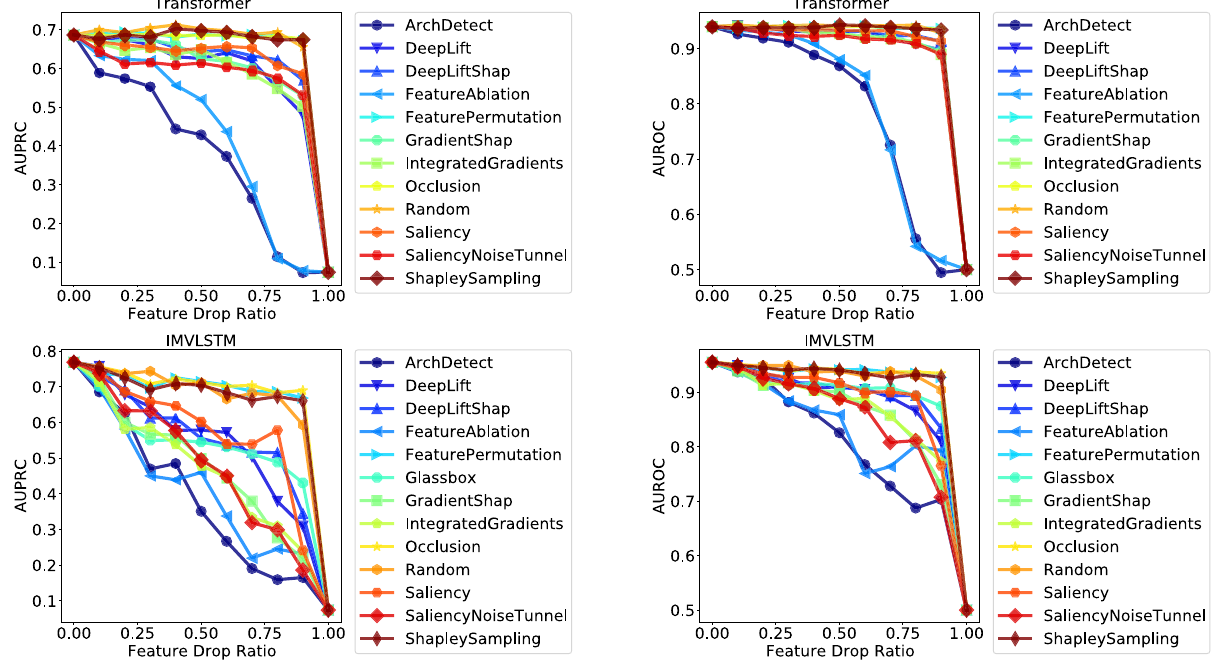
Figure 1. Curves of performance metric w.r.t feature drop ratio.